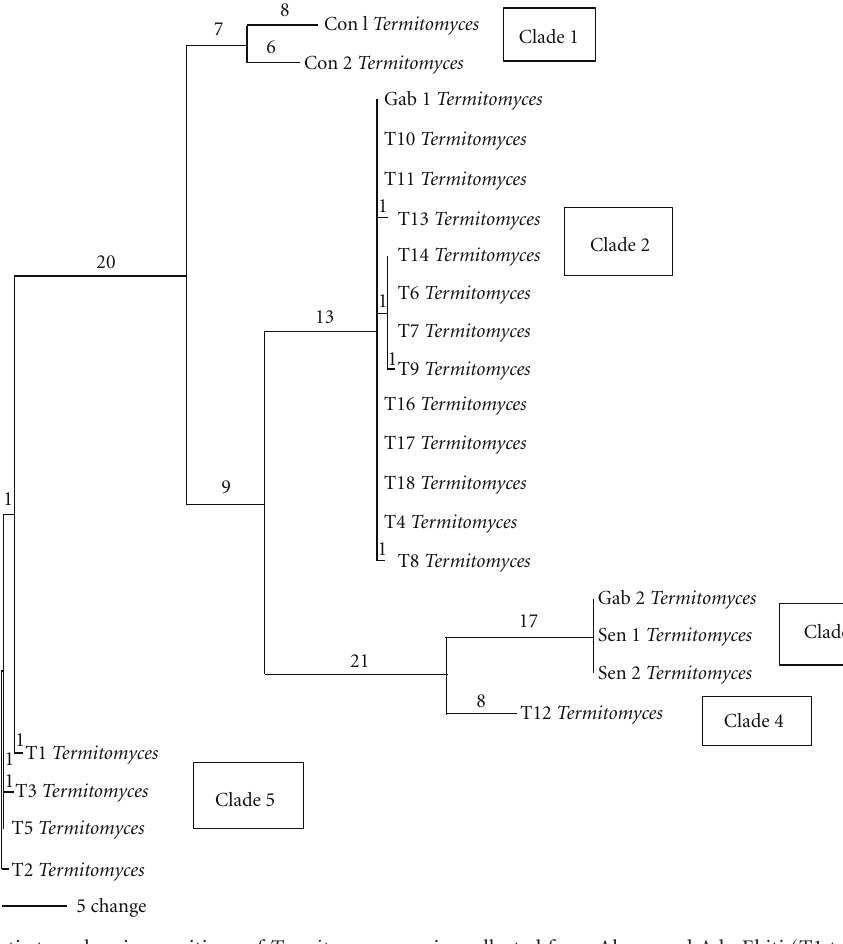
Figure 2: Phylogenetic tree showing positions of Termitomyces species collected from Akure and Ado Ekiti (T1 to T18) relative to existing sequences obtained from NCBI Genbank ITS sequence